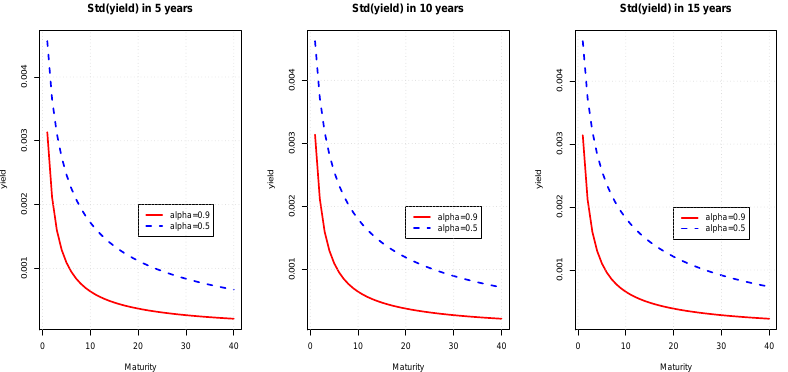
Figure 7. Expected standard deviations of yields in 5, 10 and 15 years; α = 0.5 and 0.9; β = 1.5; λ 1 = 0.5; η 1 = − 0.002; σ 1 = 0.01. ML kernel with n = 40 atoms.